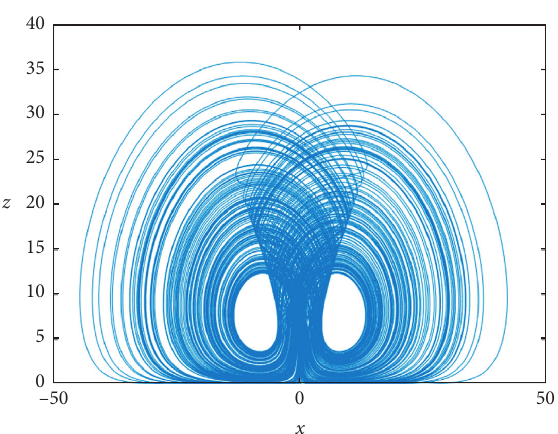
Figure 15: Dynamics of the fractional-order system in (13)–(15) with the order α � 0 . 92, in context of x , and z directions.